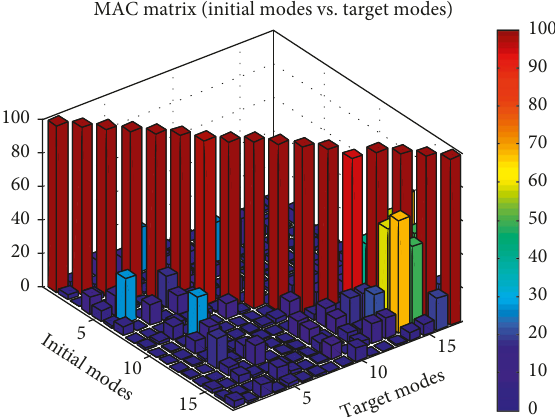
Figure 26: MAC of configuration 3 initial-target model.